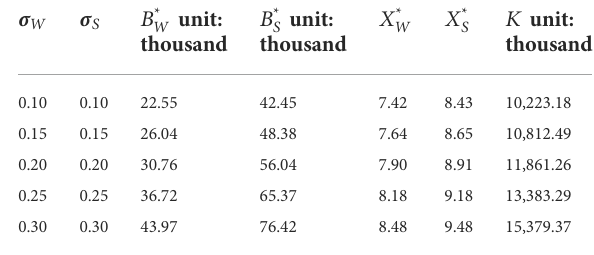
TABLE 3 The in fl uence of the α i , i (cid:2) W , S of shift variable on B * W , B * S , X * K X * W , S , and